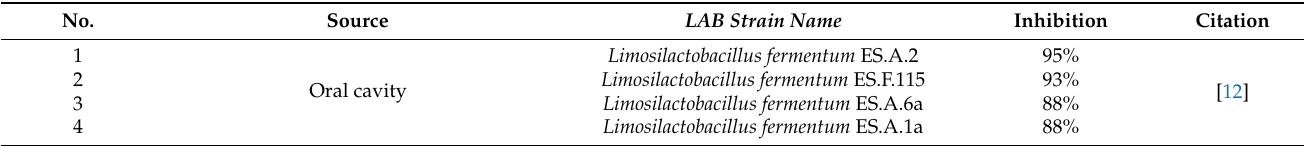
Table 1. LAB strains known to be effective against P. aeruginosa